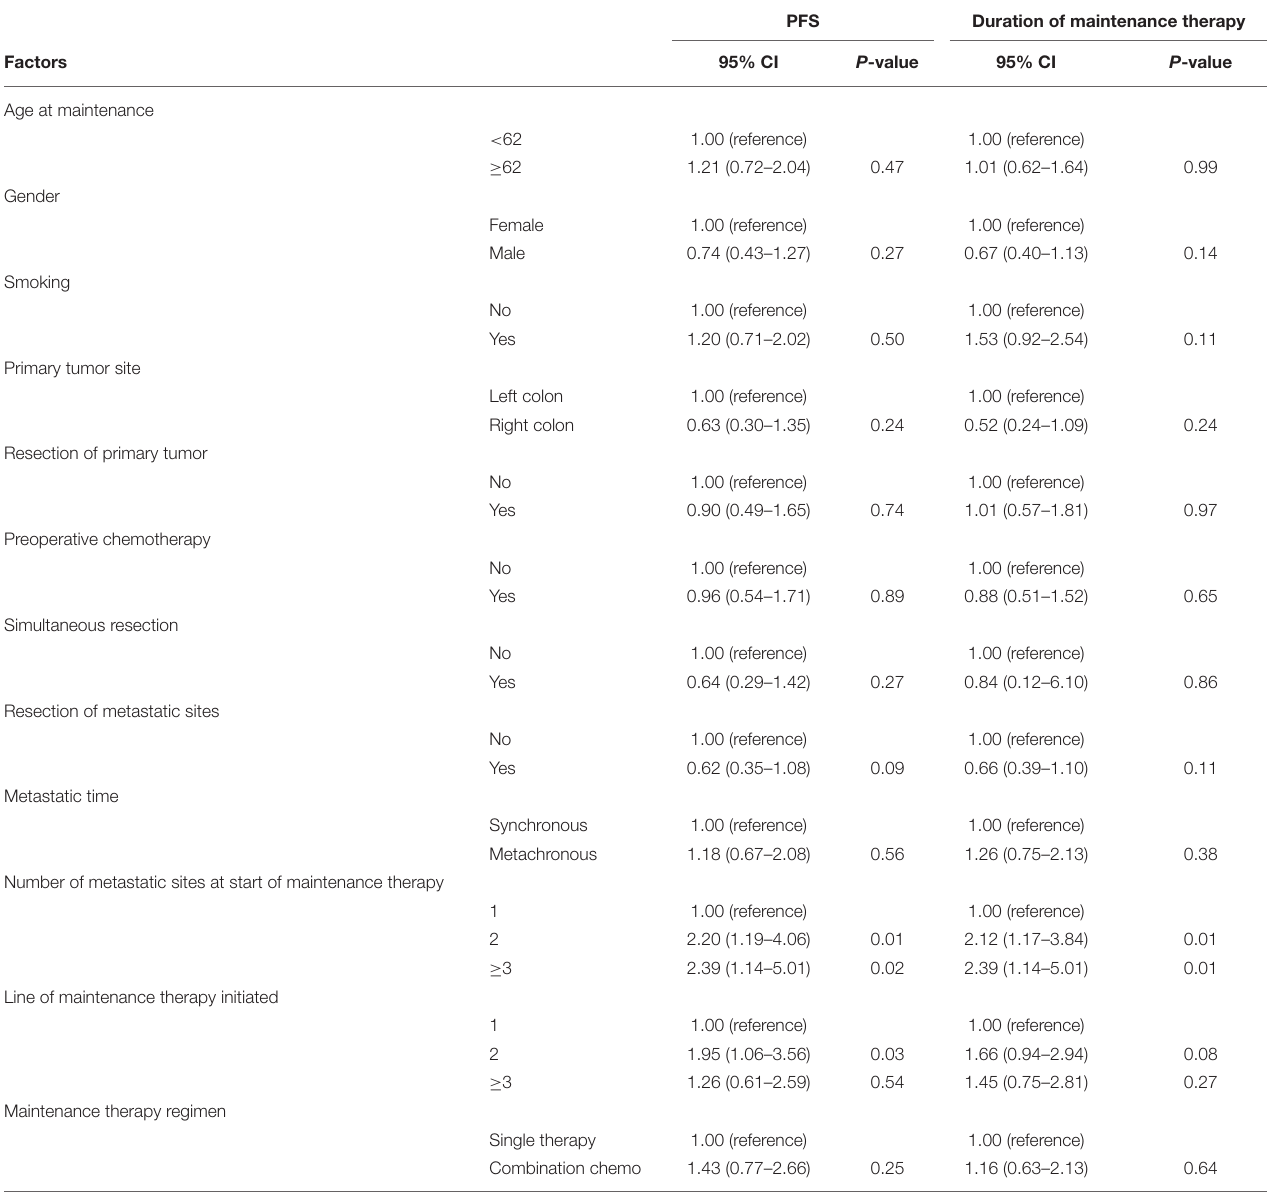
TABLE 2 | Univariate analyses for PFS and duration of maintenance therapy in Cet